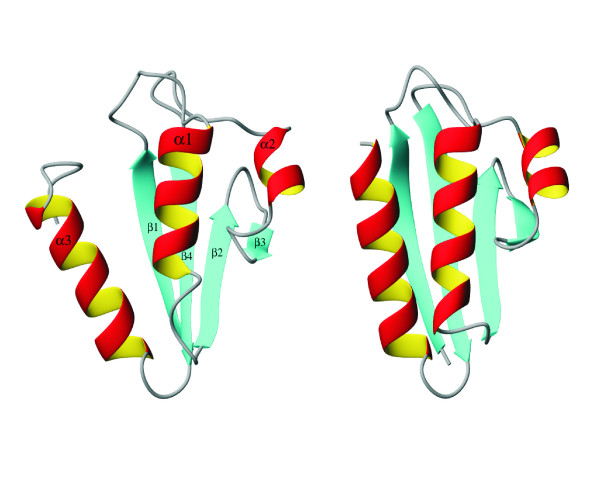
Importance of torsion angle restraints exemplified on HPr from Streptococcus faecalis. On the left hand side the model structure calculated with PERMOL using 427 torsion angle restraints and 41 hydrogen bonds is displayed, while on the right hand side the target X-ray structure 1PTF is shown. The RMSD value for the heavy atoms of the two structures is 0.328 nm. Restraints for torsion angles and hydrogen bonds were directly generated from the X-ray structure 1PTF.